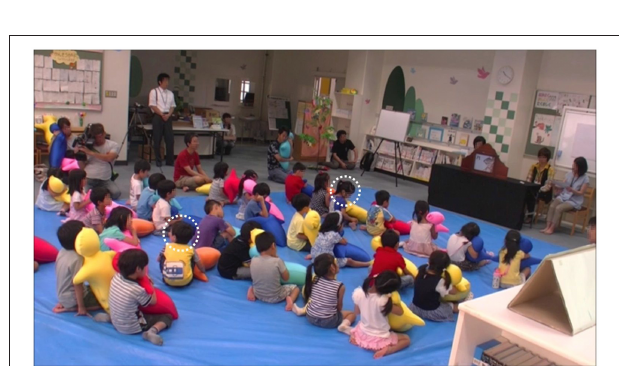
FIGURE 4 | Storytime with Hugvie (12 min. later): two of 30 children (total number countable from this figure) became distracted (white dotted circles).